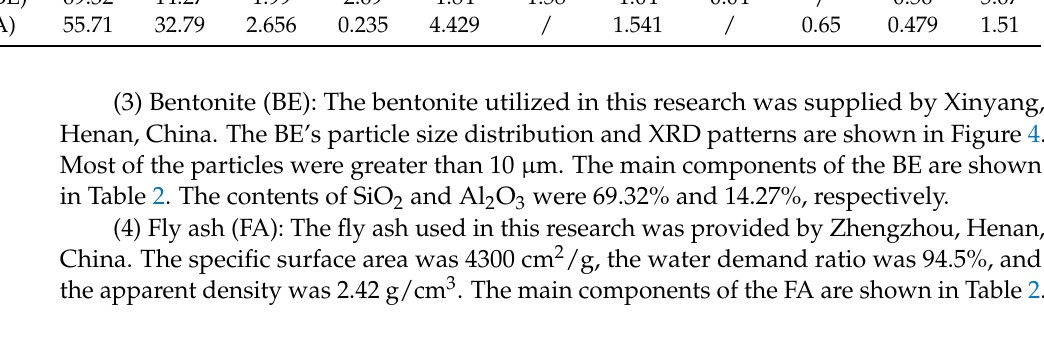
Table 3. The orthogonal experiment (Wt%).